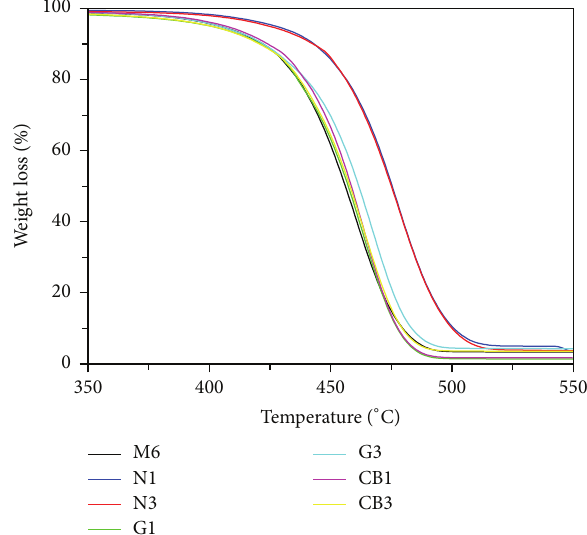
Figure 5: TGA curves of